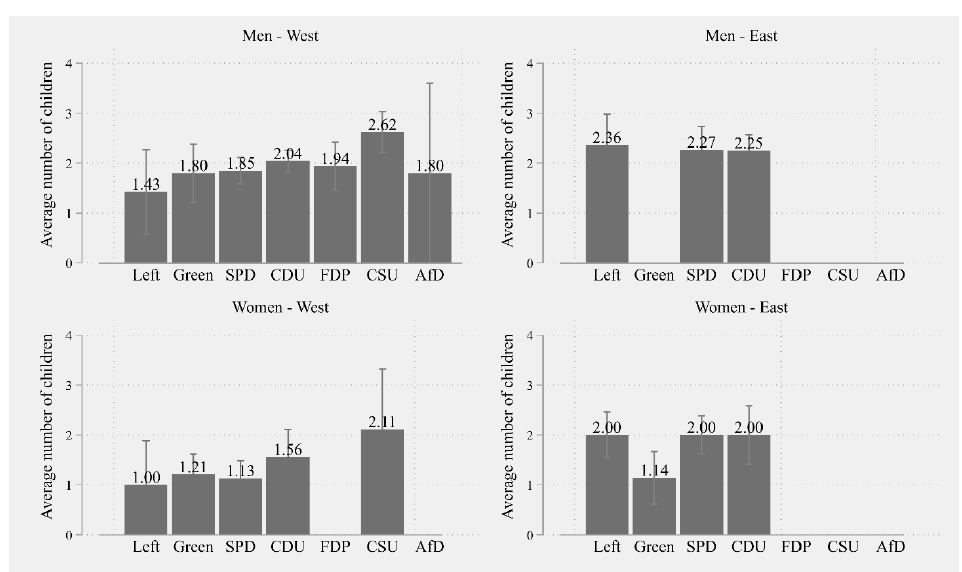
Figure 2 : Average number of politicians’ children by gender, region, and party affiliation. Groups with less than five observations left blank. 95%-confidence intervals displayed. Parties sorted by left-right scale, based on the widely-used Chapel Hill expert survey (Polk et al.